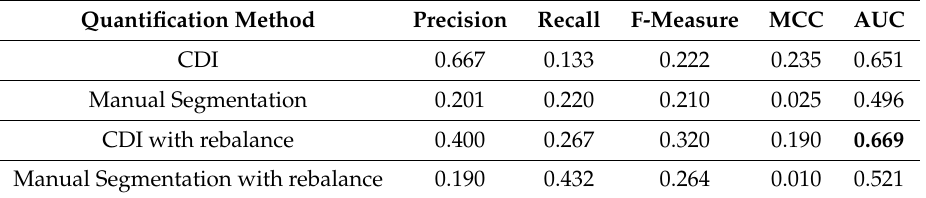
Table 2. Prediction performance of artificial neural network (ANN) using bottom CDI locations and manual segmentation on X1